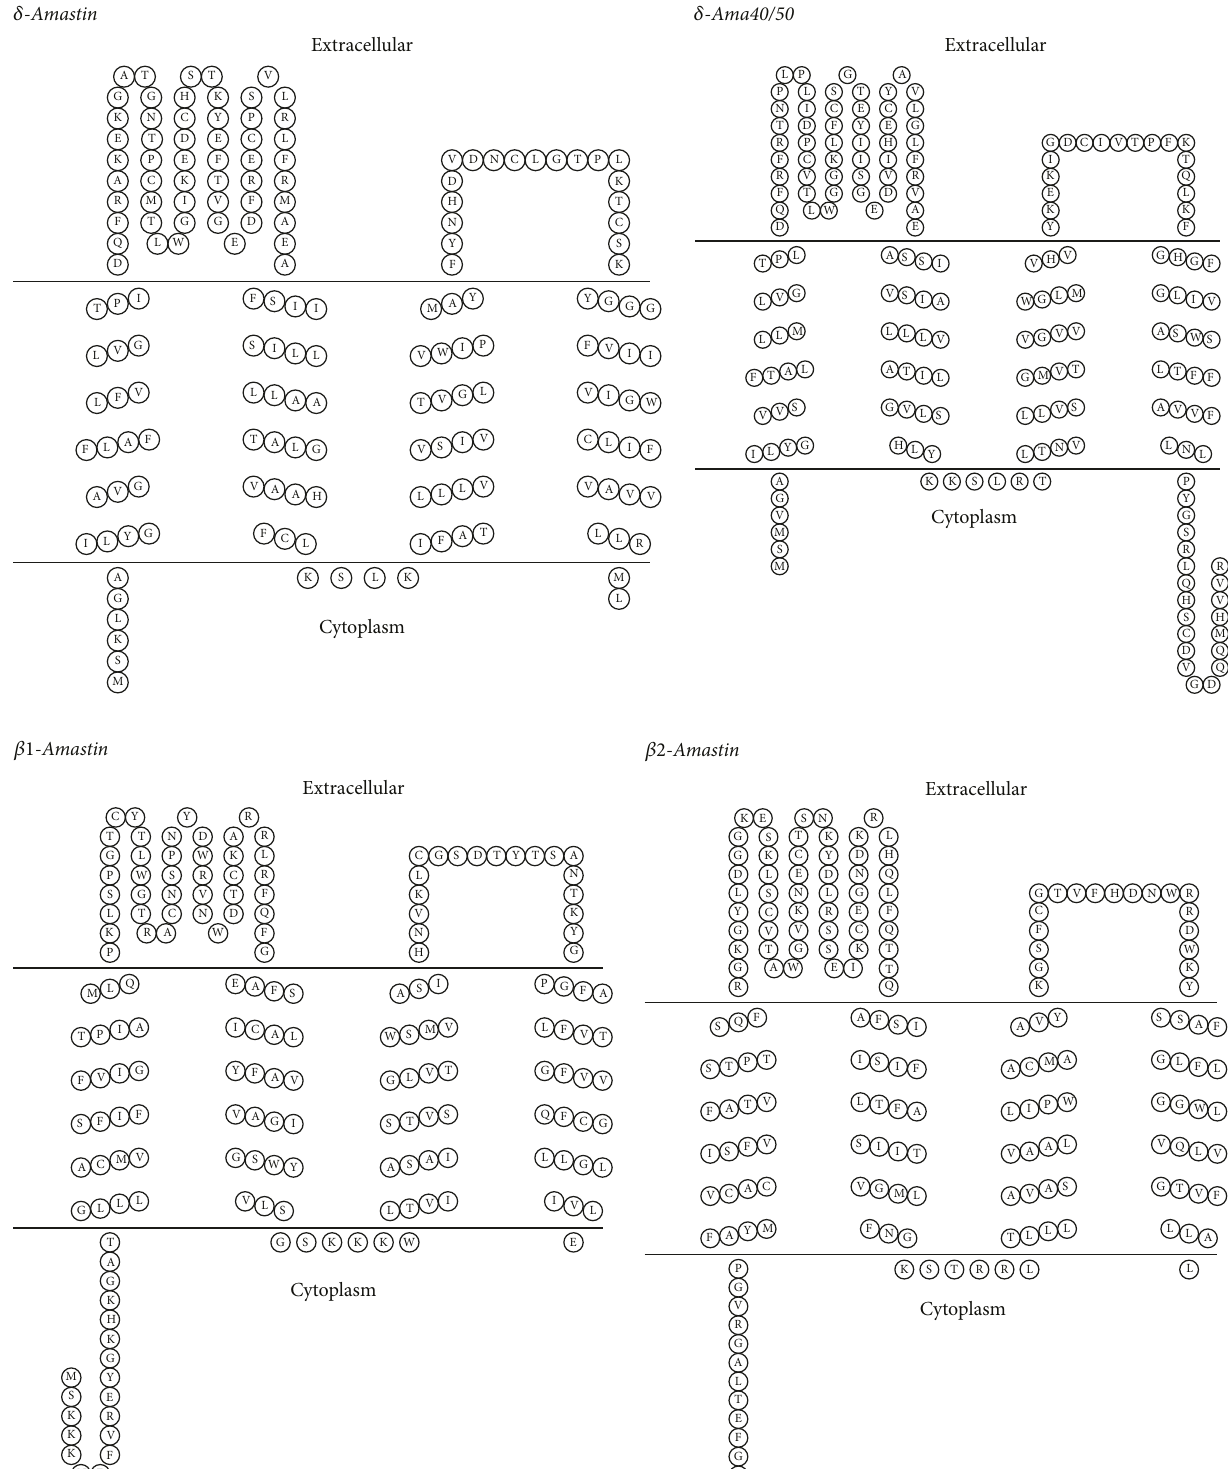
FFVREYGKHKGATG Figure 5: Amastin family. Topological model of subfamilies 𝛽 - and 𝛿 -amastins from Trypanosoma cruzi . Amastins models share four predicted transmembrane helices and two extracellular hydrophilic loops. Although both N- and C-termini are predicted to be facing the cytoplasmic space, their length is variable among them. Topology predictions were performed using the “TOPO2, transmembrane protein display software”